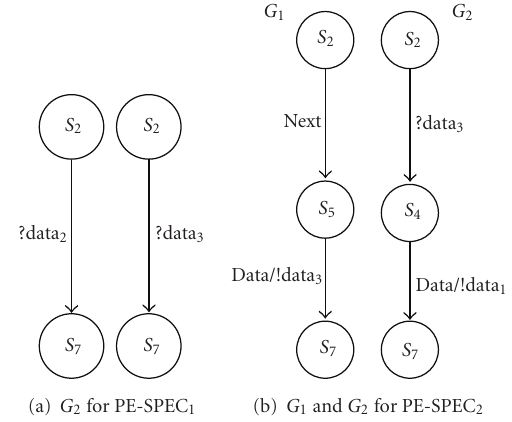
Figure 4: Application of partitioning procedure on the PE-SPECs given in Figure